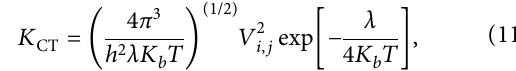
Fe 2+ , Co 2+ , Ni 2+ , Cu 2+ , and Zn 2+ (cid:29)